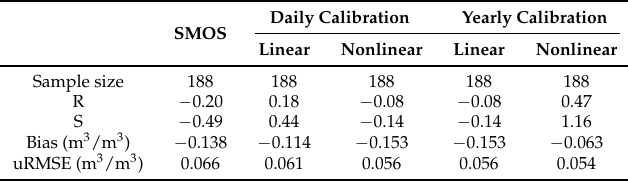
Table 6. Same as Table 4, but for Algerri-Balaguer.